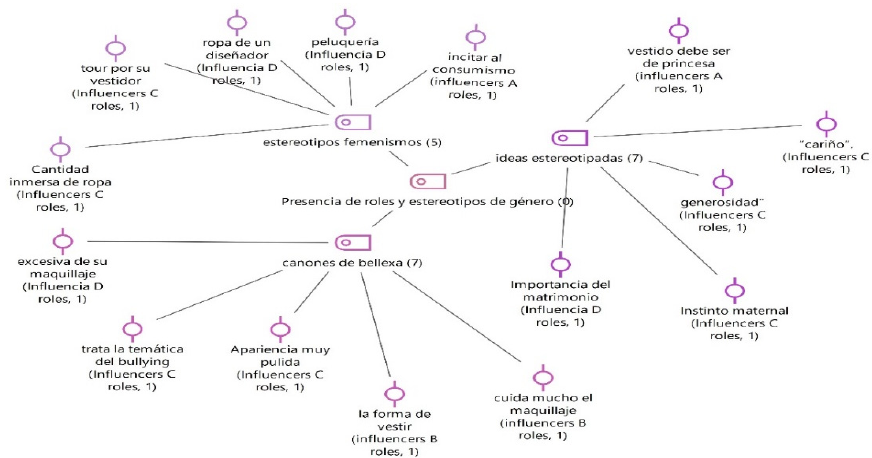
Figure 2. Categories and codes: Gender roles and stereotypes. 4